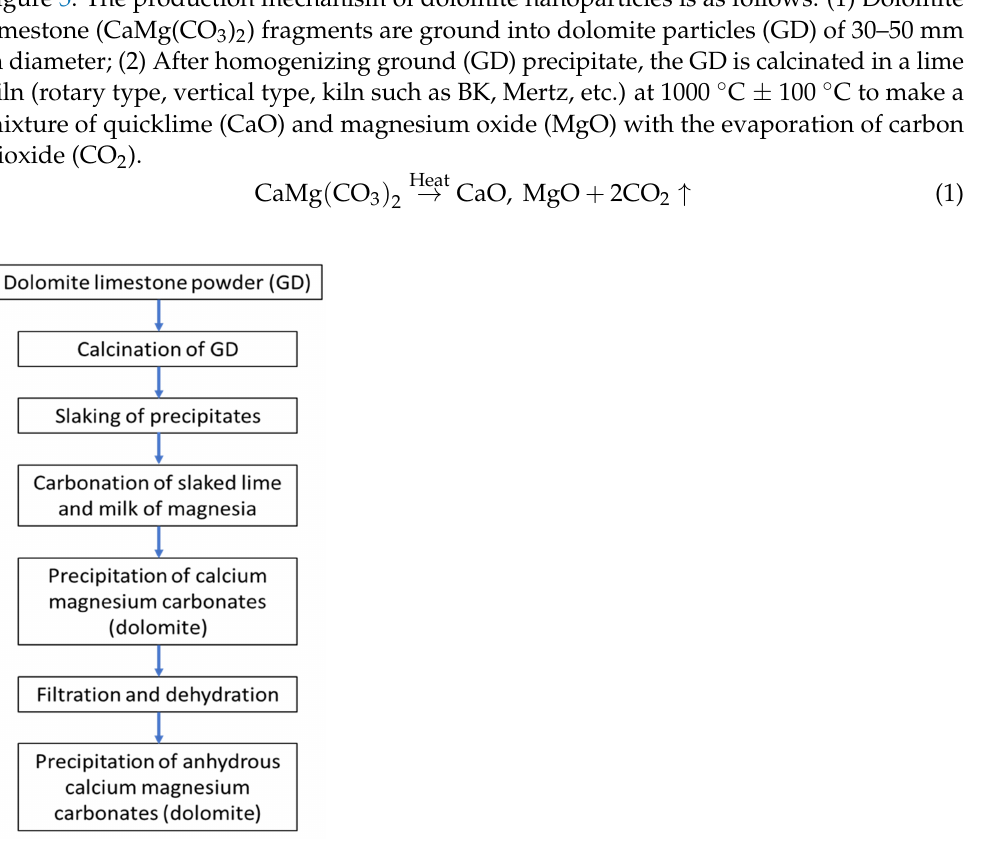
Figure 5. Production mechanism of dolomite nanoparticles from dolomite limestone by colloidal precipitation method.